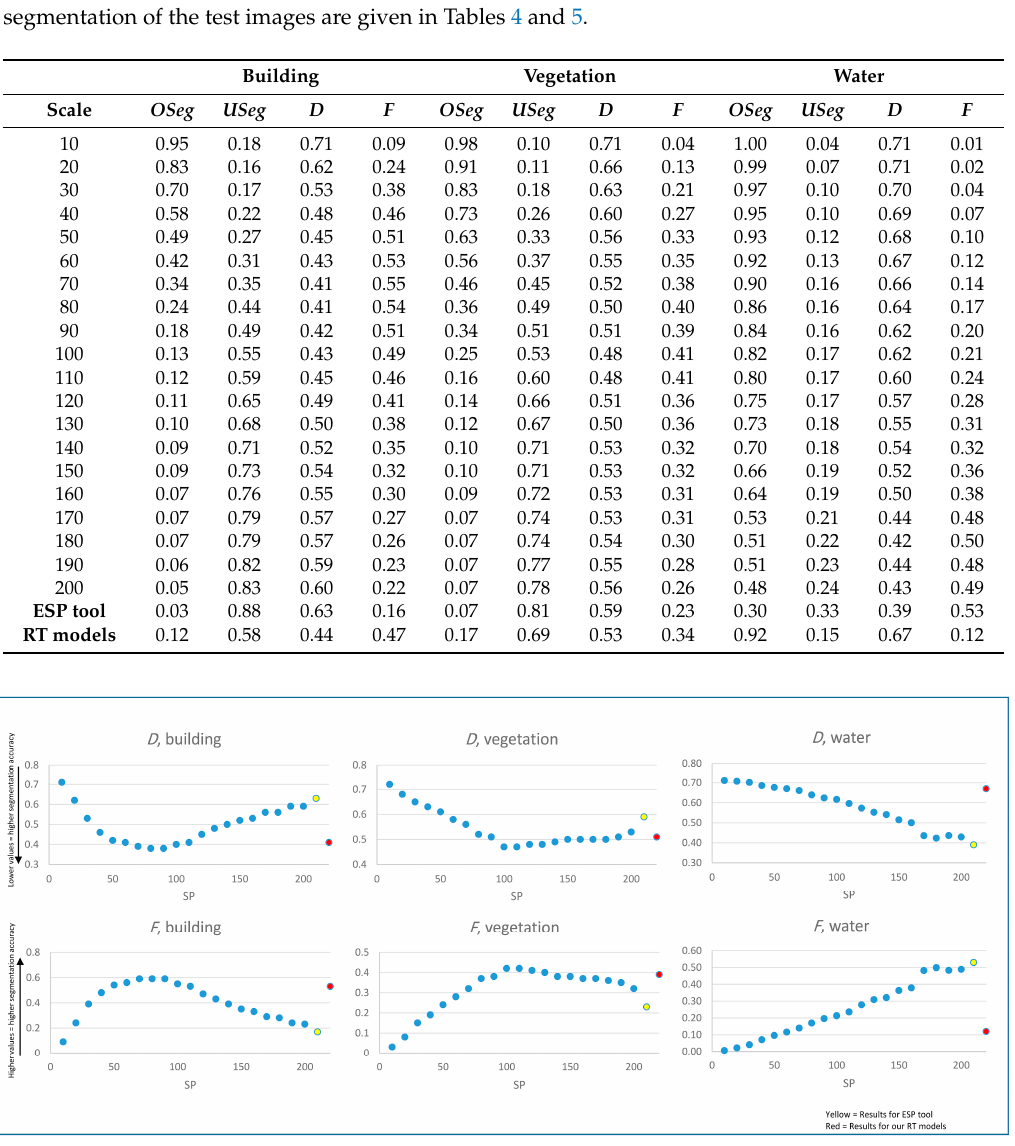
Figure8. Chart of the D and F values for the building, vegetation, and water classes. Figure 8. Chart of the D and F values for the building, vegetation, and water